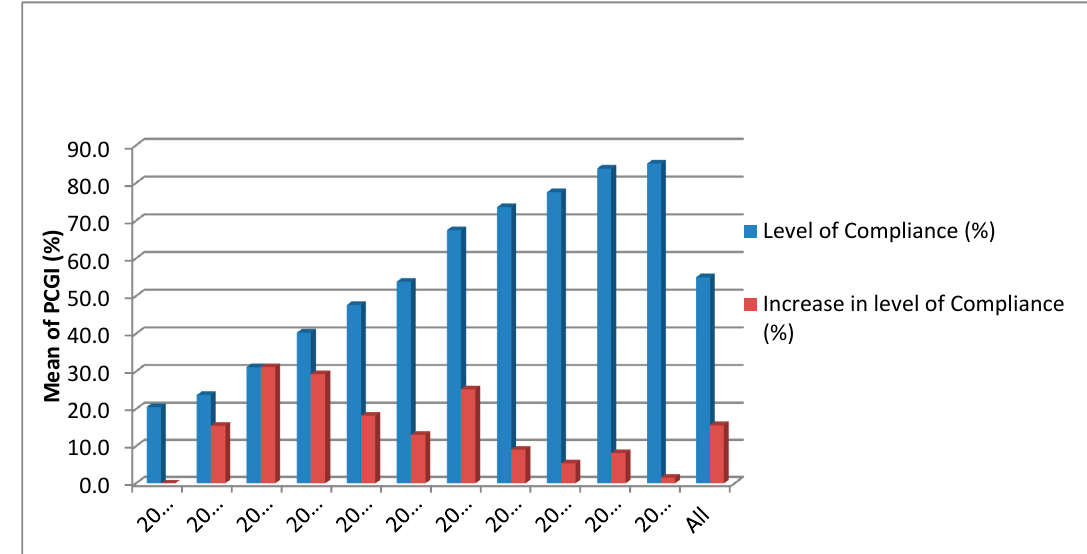
Figure 1. The compliance level with Pakistani Corporate Governance Index (PCGI) based on the full sample. Note on the authors’ calculation: The level of compliance is calculated by using the yearly average of PCGI. The year-wise increase in the level of compliance is also presented in Figure 1. The blue bar of the graph shows a constant increase in the level of compliance over the sample period. However, the increase in the level of compliance varies from year to year. For instance, in the beginning, years, there is a rise of 10 to 30%, which decreases to less than 5% in the last years. This is because most of the firms started following the corporate governance (CG) standards.